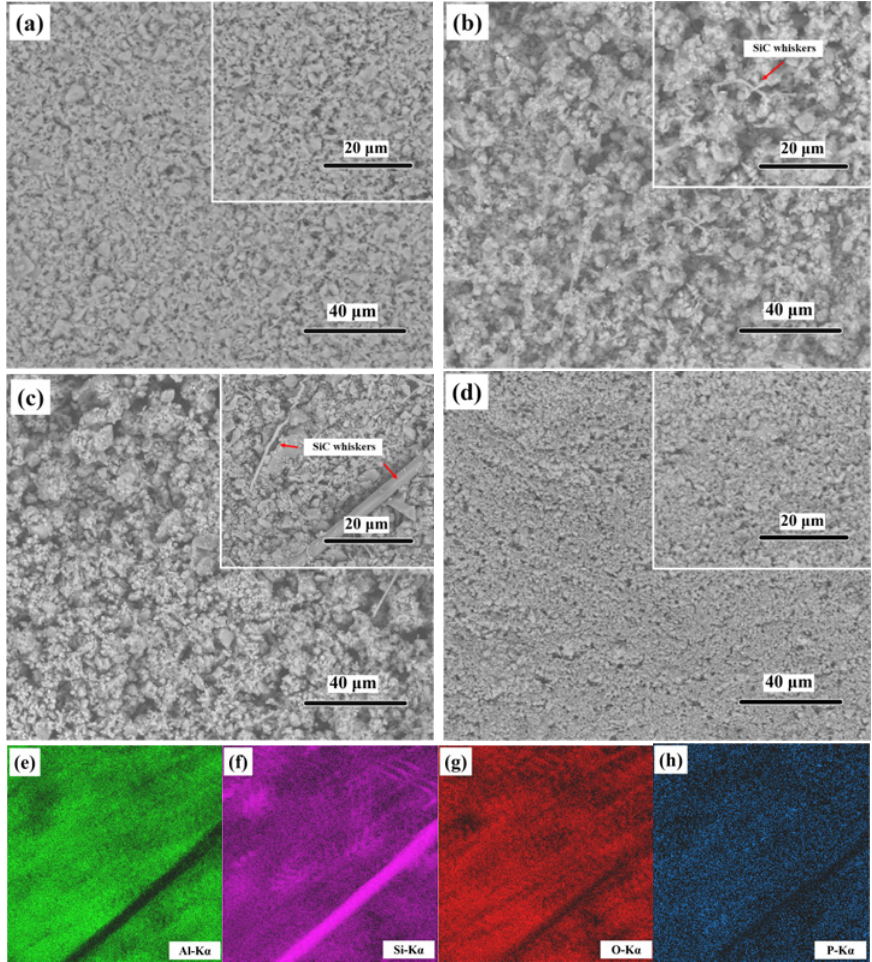
Fig. 4 Surface microstructure images of (a) mullite, (b) SM, (c) ASM middle coatings, and (d) Yb 2 Si 2 O 7 outer